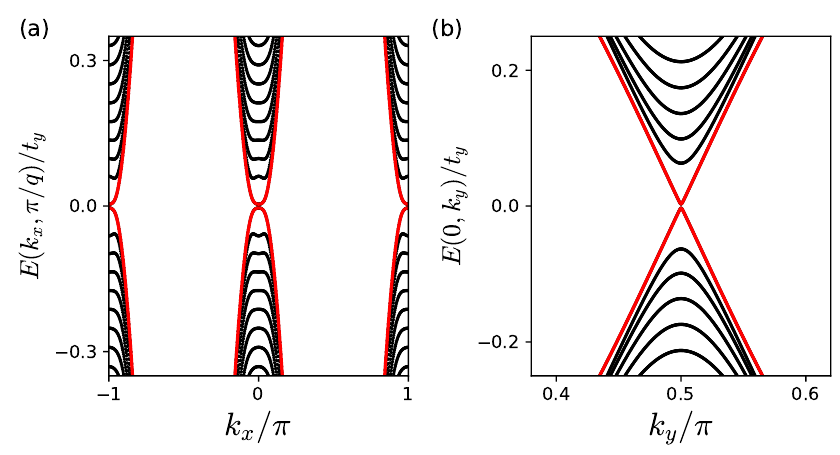
Figure 7: The low energy dispersion of the surface states when the system is a finite = 80, for q = 2. The parameters M and t slab along the z -direction with L z chosen so that the system is at the boundary between phases W2 and W4. See the caption of Fig. 6 for the choice of parameters. The surface bands (red) touch (a) quadratically in k and (b) linearly along k . The low energy surface band x y